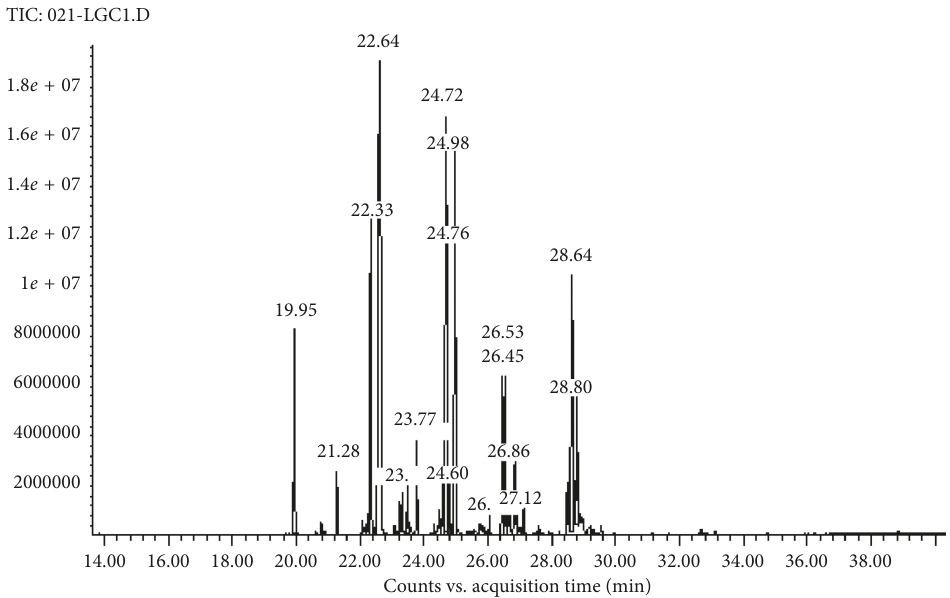
Figure 4: Gas chromatography-mass spectrometry of Amazon sailfin catfish biodiesel.